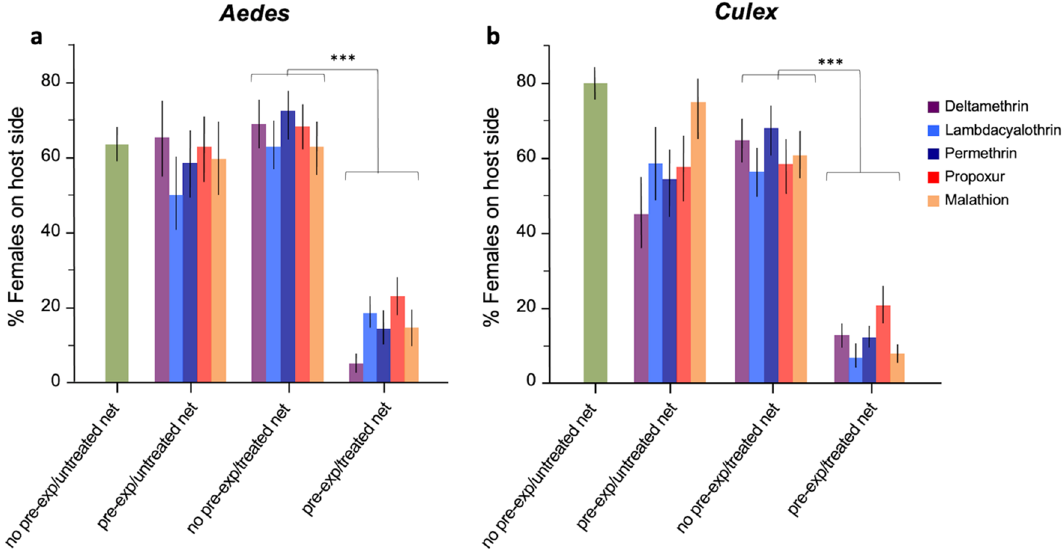
Figure 2. The proportion unconditioned and conditioned females of ( a ) Aedes aegypti and ( b ) Culex quinquefasciatus found on the host side when exposed to untreated and treated bed nets during the tunnels test. Error bars represent 95% confidence intervals. P values are P < 0.001